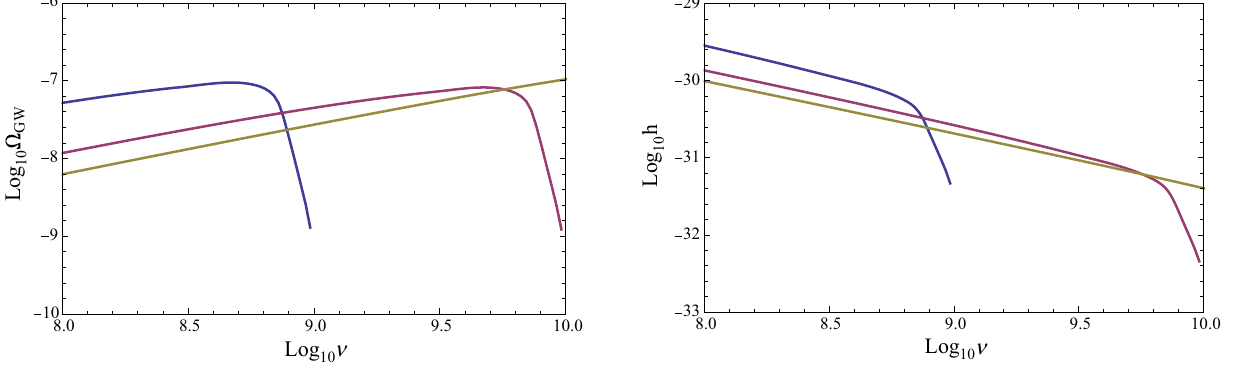
Fig. 1 The SGWB energy density spectrum for various chirp masses, M c = 10 − 5 M (cid:2) , 10 − 6 M (cid:2) , 10 − 7 M (cid:2) , shown by the blue curve, the pur- ple curve, and the brown curve, respectively